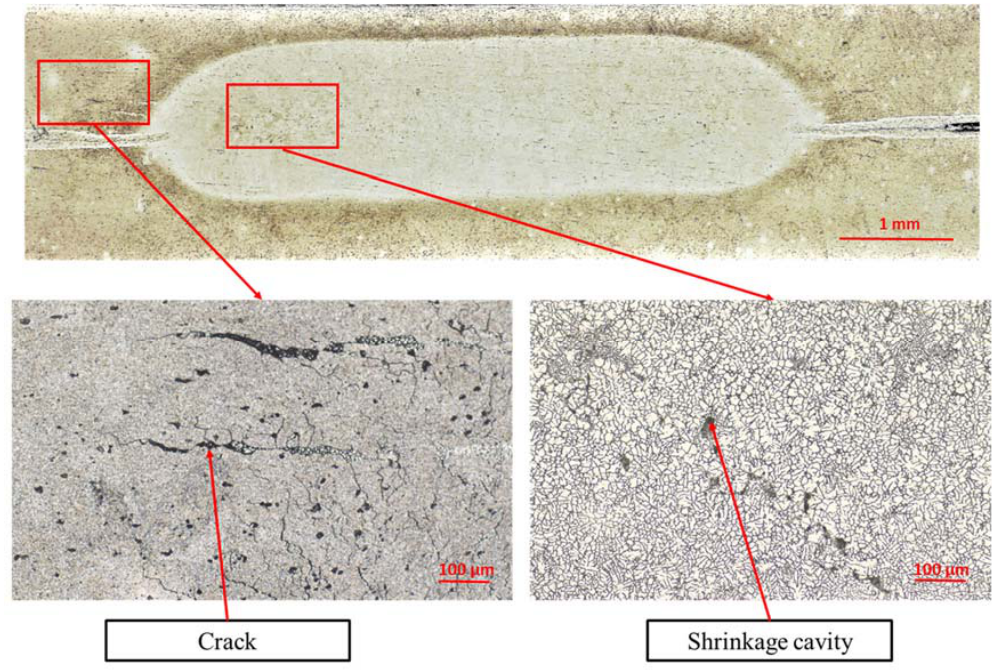
Figure 7. Microstructural discrepancies in RSW joints. Materials 2020 , 13 , x FOR PEER REVIEW